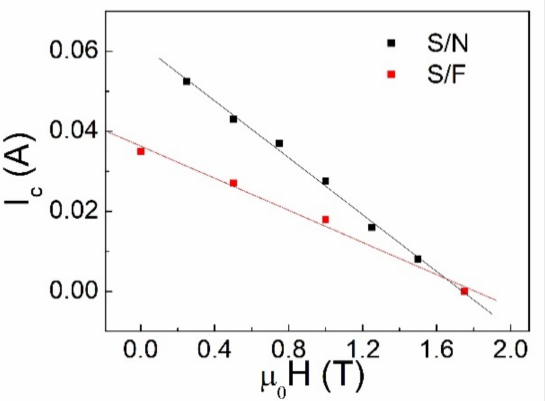
Figure 6. Dependence of I c on the external applied field for Nb/Pd 0.84 Ni 0.16 and Nb/Al bilayers (the lines are a visual